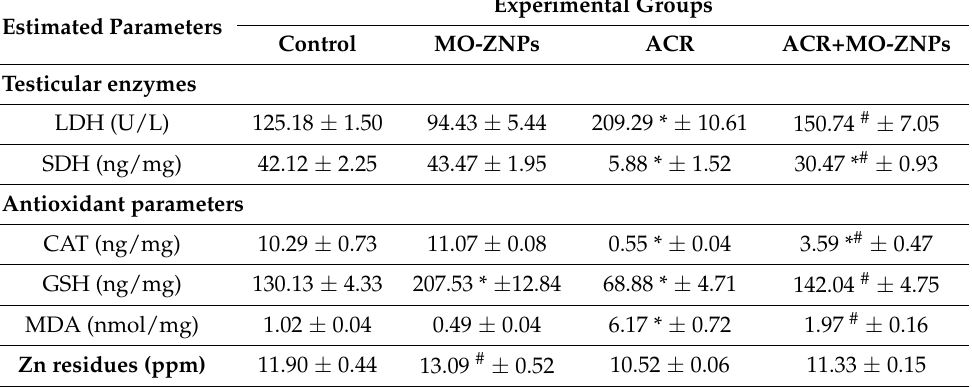
Table 4. Effect of green synthesized zinc oxide nanoparticles produced by Moringa oleifera leaf extract (MO-ZNPs) on testicular enzymes, antioxidant status, and Zn content in the testis of acrylamide (ACR)-exposed